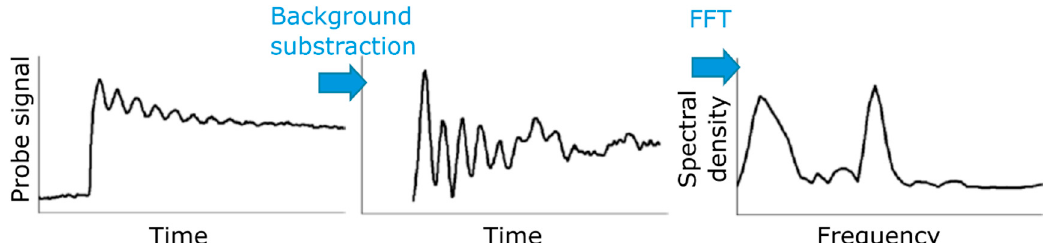
Figure 4. Typical processing of the optical signal measured in time-domain investigations in order to extract the oscillating components related to the coherent phonons, and the corresponding acoustic spectrum. From [137], published by the American Physical Society under Creative Commons.